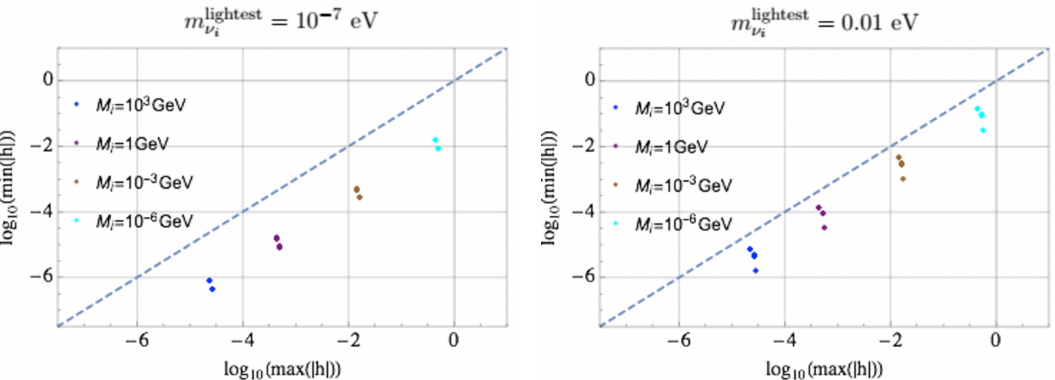
Figure 4 . Case M i < Λ i : allowed points in terms of max ( | h | ) versus min ( | h | ) for various M i ≡ M 1 = M 2 = M 3 values. The loop-induced neutrino masses are from eq. (3.36). The dashed line corresponds to maximally anarchic HY matrix, i.e. max ( | h | ) = min ( | h | ) . In the left and right panel, the mass of the lightest neutrino is m lightest = 10 − 7 and 0 . 01 eV, respectively, for both NH and IH. ν i